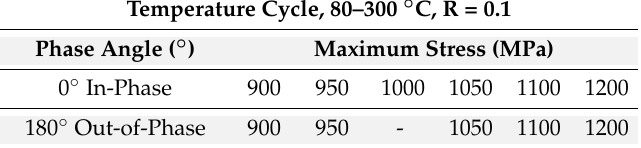
Table 1. TMF test matrix for 80–300 ◦ C temperature cycle, with test conditions shown for in-phase and out-of-phase